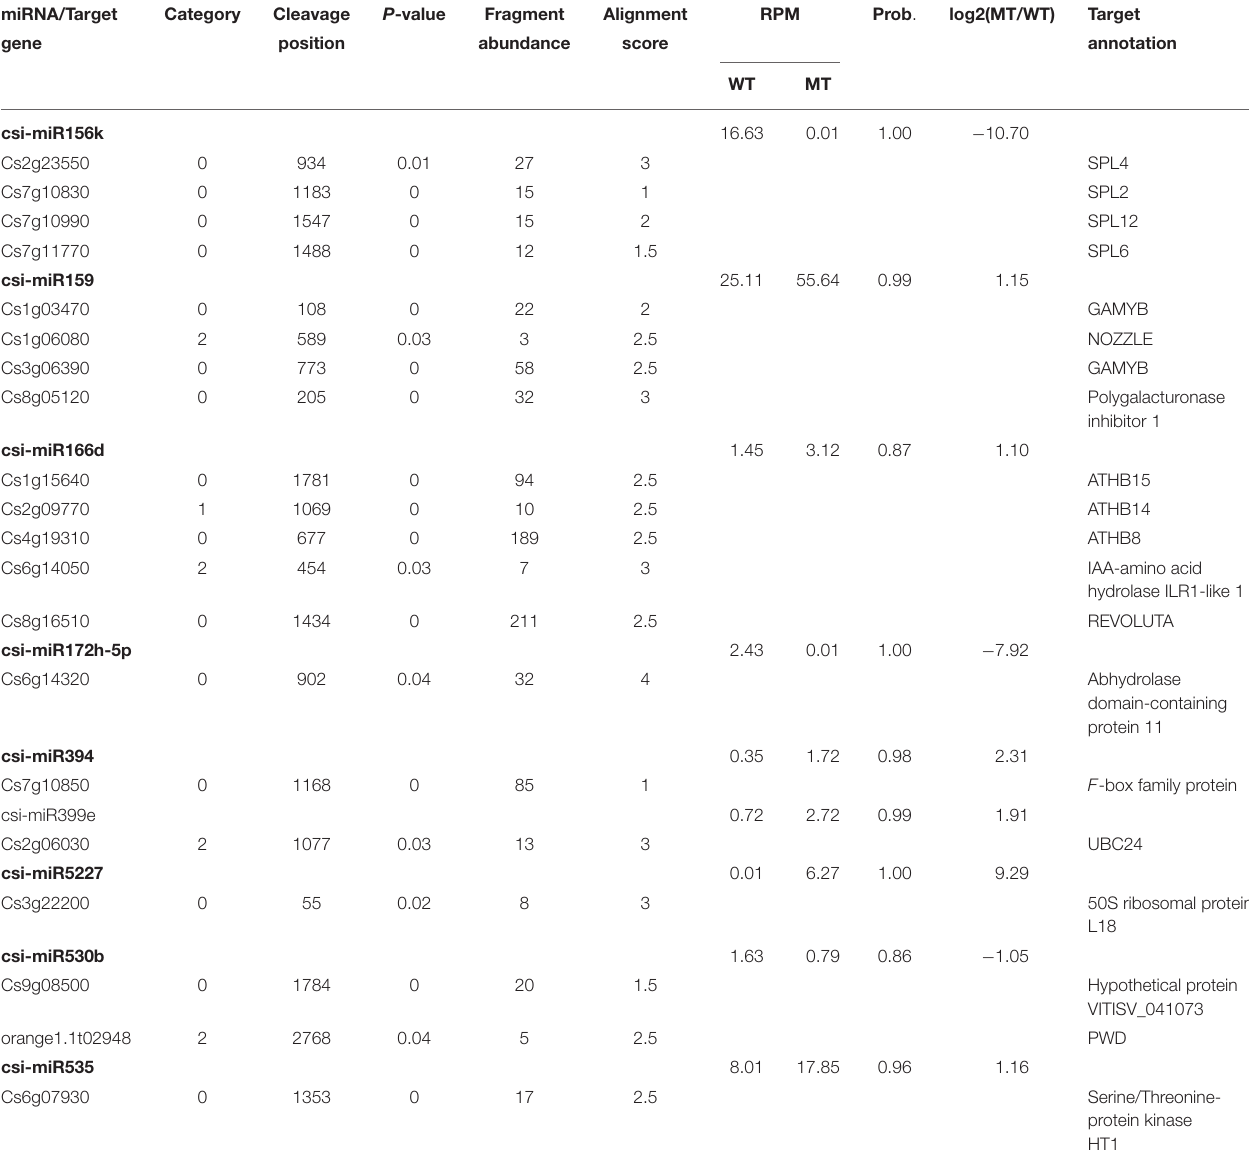
TABLE 2 | Targets of the known miRNAs identified in MT and WT.